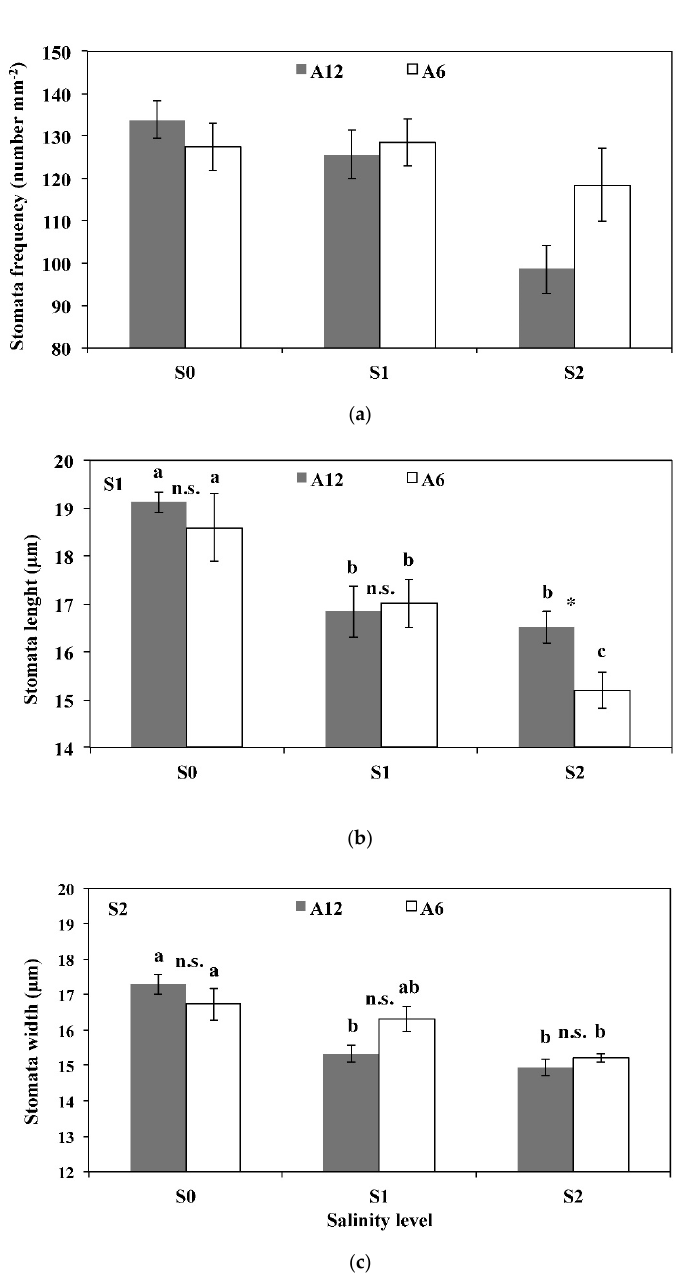
Figure 5. Stomatal frequency ( n ¨ mm ´ 2 ), length, and width ( µ m) in response to different salinity levels (S0, S1, and S2) of two accessions A6 and A12. a–c: the letters denote statistically significant differences among salinity levels for each accession ( p = 0.01; SNK test); the stars denote statistically significant differences between the two accessions for each salinity level (* p = 0.05; ** p = 0.01, n.s. not significant; t -test). ( a ) represents the stomata frequency; ( b ) represents the stomata length; ( c ) represents the stomata width under the different